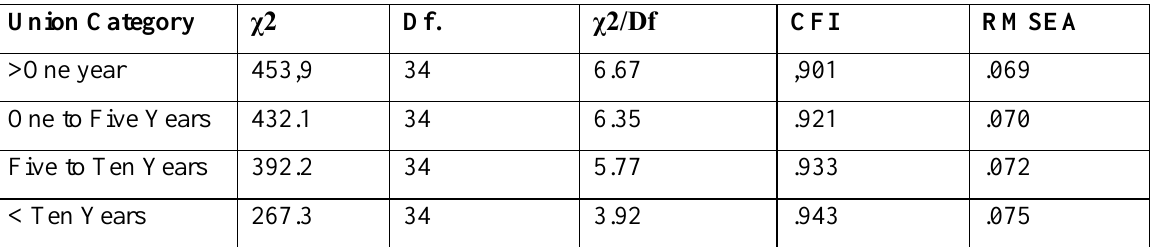
Table II: Model fit Statistics across